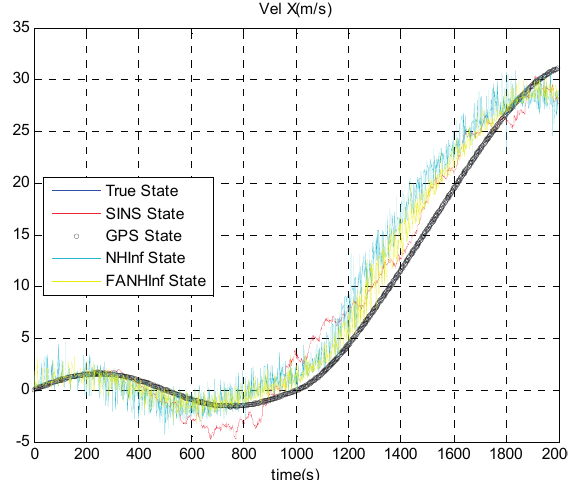
Figure 7. Estimation of the velocity following the North